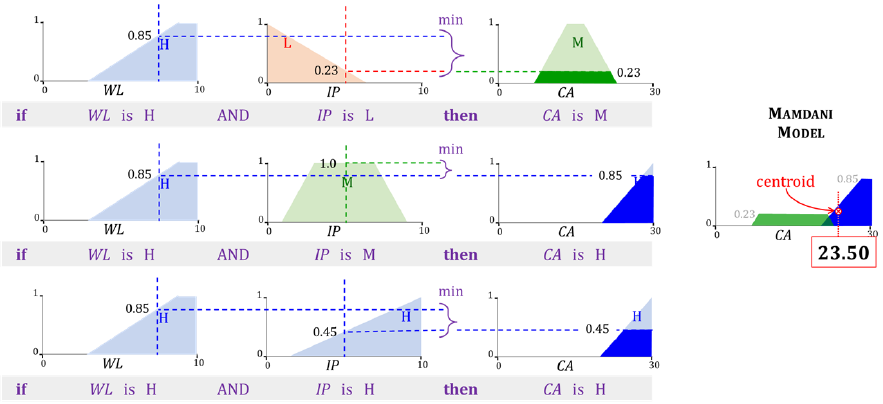
Figure 10. Mamdani FIS. The inputs to the FIS in Figure 9 are WL = 7.5 and WL = 5.0 (dotted vertical lines), and the output is y = 23.50). The first three rules in Figure 9 with WL = H are ignored since µ L ( 7.5 )= 0 ) . The dark-shaded regions are R k of the relevant rules.